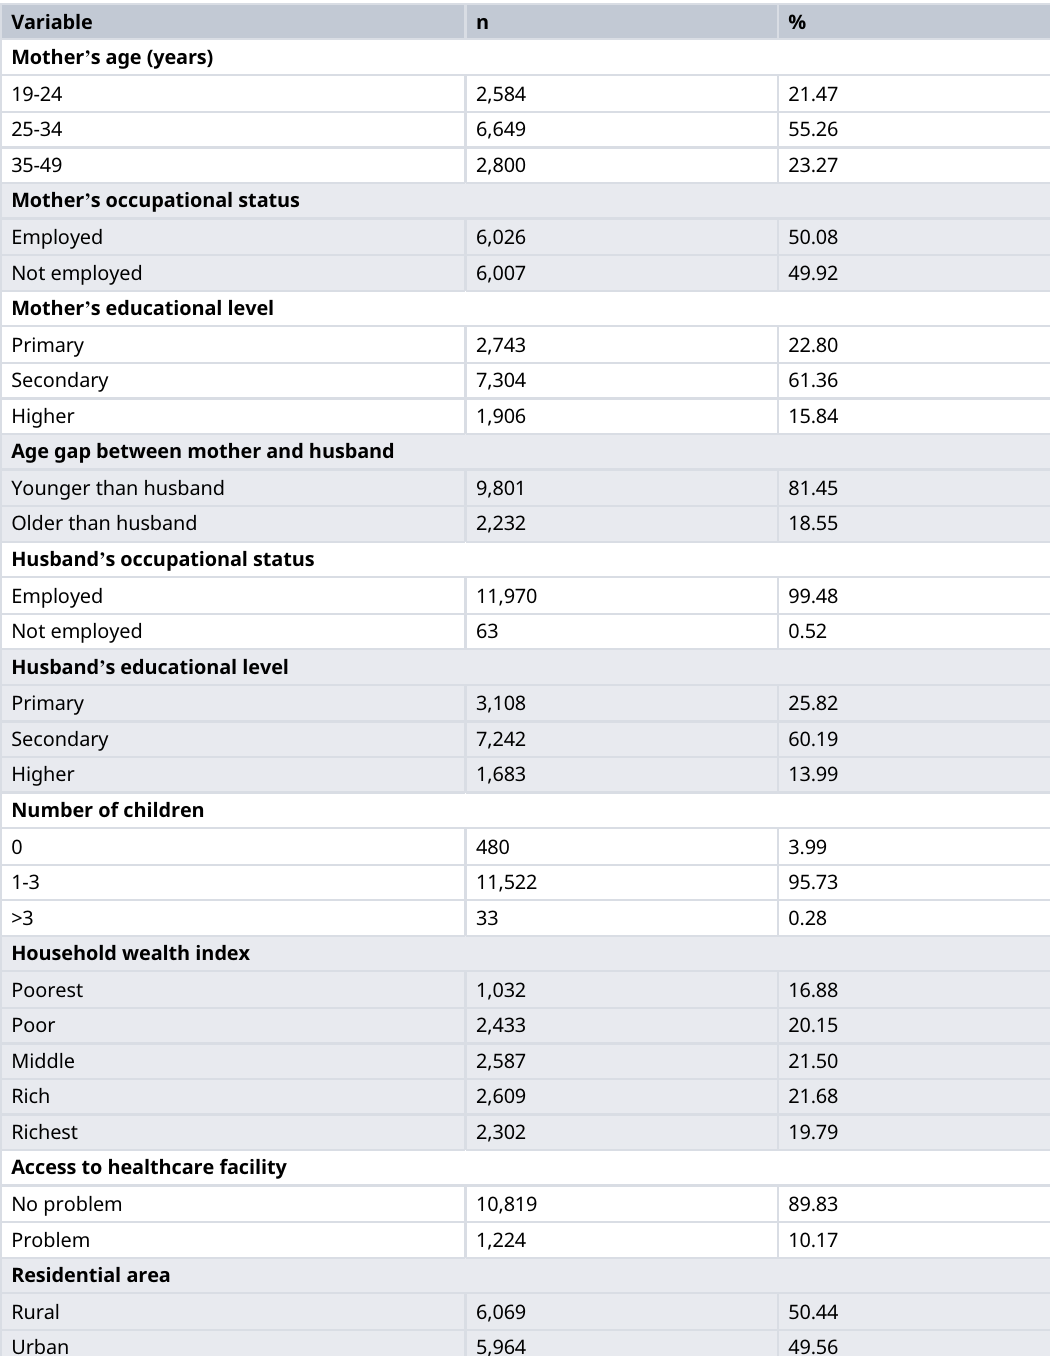
Table 1. Participants characteristics (n =